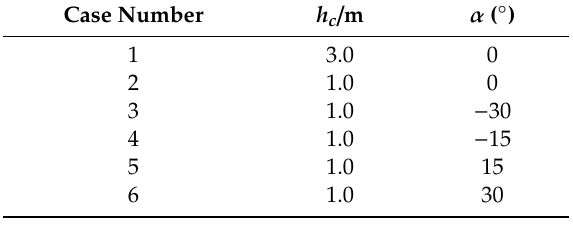
Table 2. Parameters of numerical cases.